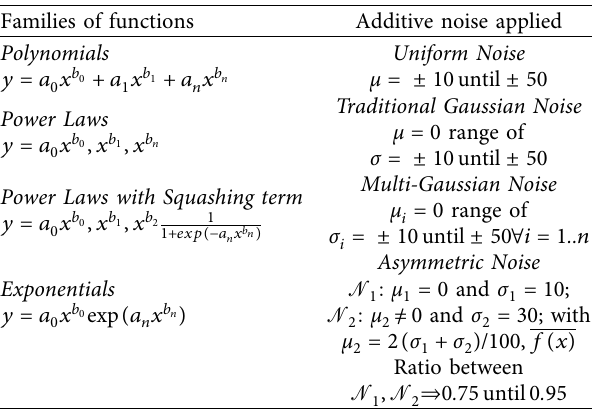
Table 2: The main families of functions tested and the statistics of the additive